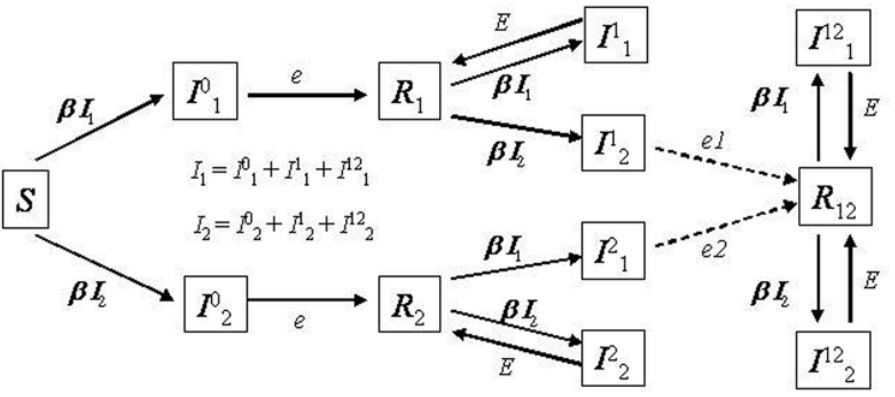
Figure 1. SIR model with reinfection and selection. I i ,j means a host that has been infected with the i th strain and is currently carrying pathogen strain j . e i are the different possible rates of recovery from the current infection, when all e i are equal we have a neutral model with reinfection. R i means that the host has recovered from infection with strain i . We have simulated a strong selective advantage of the new strain by setting e =0.1 and E =7* e ; e 1 =3* e and e 2 =7* e .